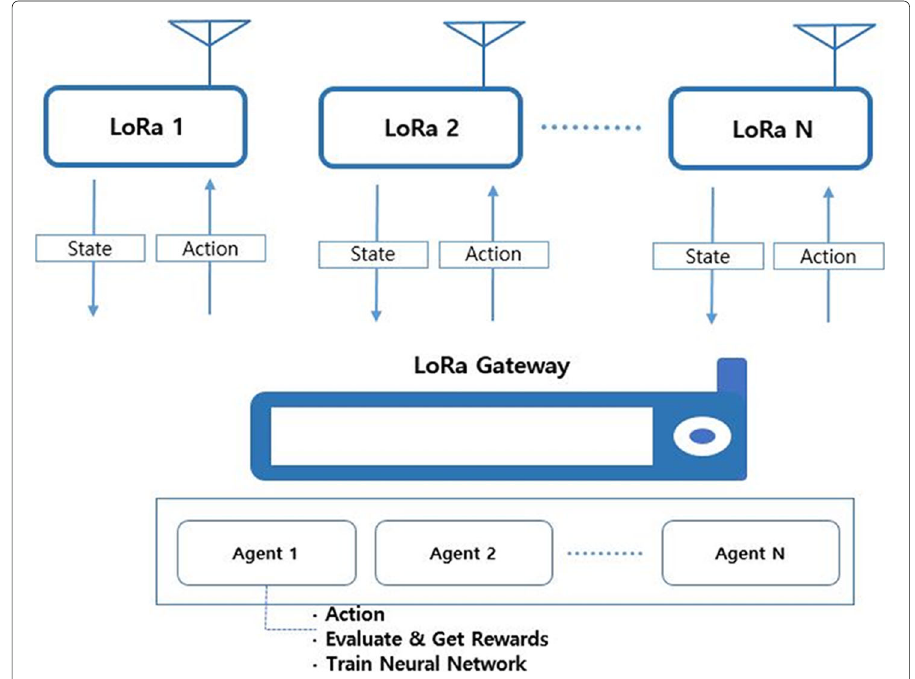
Fig. 2 LoRa reinforcement learning model